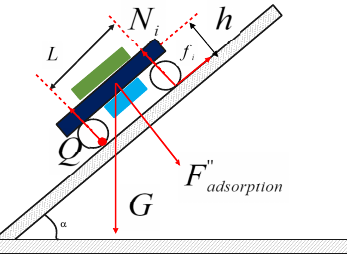
Figure 3. Schematic diagram of the static analysis under State B.